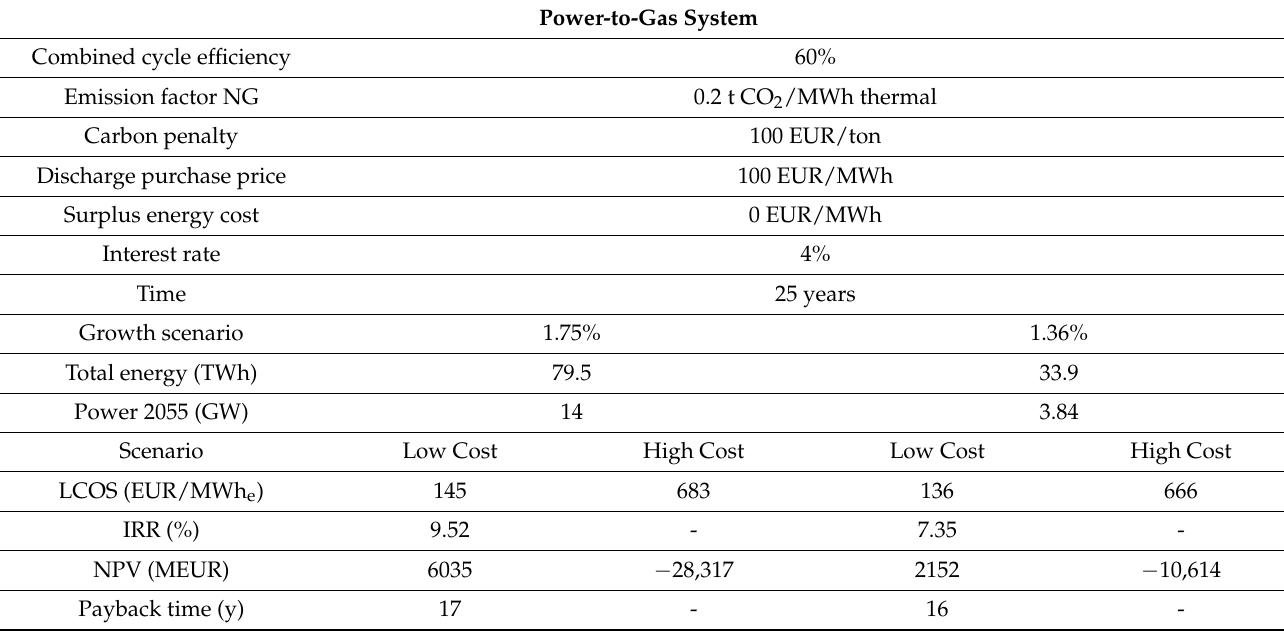
Table 2. Results of the analysis of the reference case for Spain. Power-to-Gas System